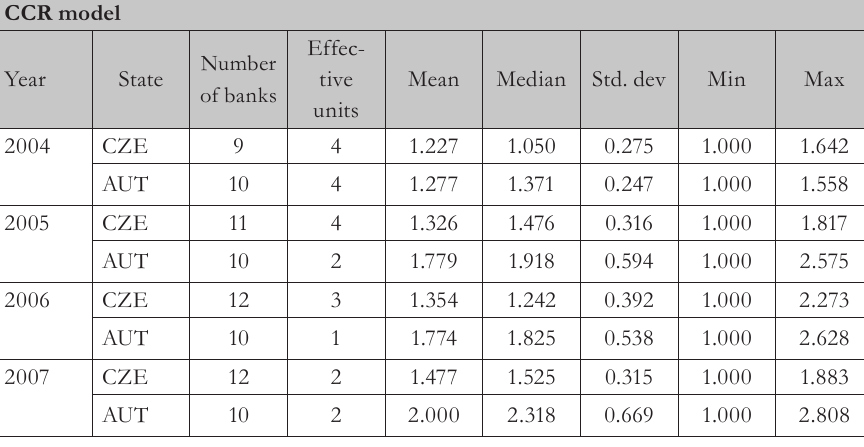
Tab. 3 – Descriptive statistics of measured units. Source: Author´s